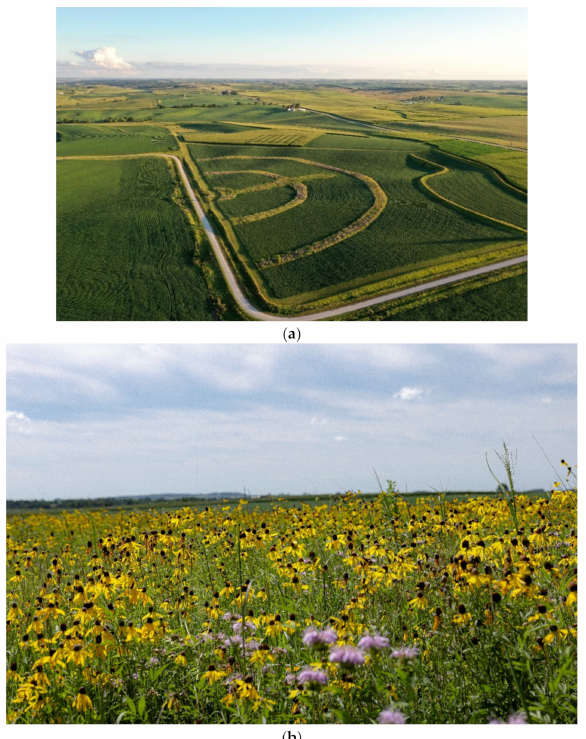
Figure 1. Two views of prairie strips at different anonymized locations in Iowa, USA ( a ) Aerial view of prairie strips (lighter color) and corn (darker color). White represents roadway. ( b ) Close-up of prairie strips, 2–3 years after establishment, with purple wild bergamot ( Monarda fistulosa ) at bottom of photo; and gray-headed coneflower ( Ratibida pinnata ) (yellow) in abundance. Photos ISU